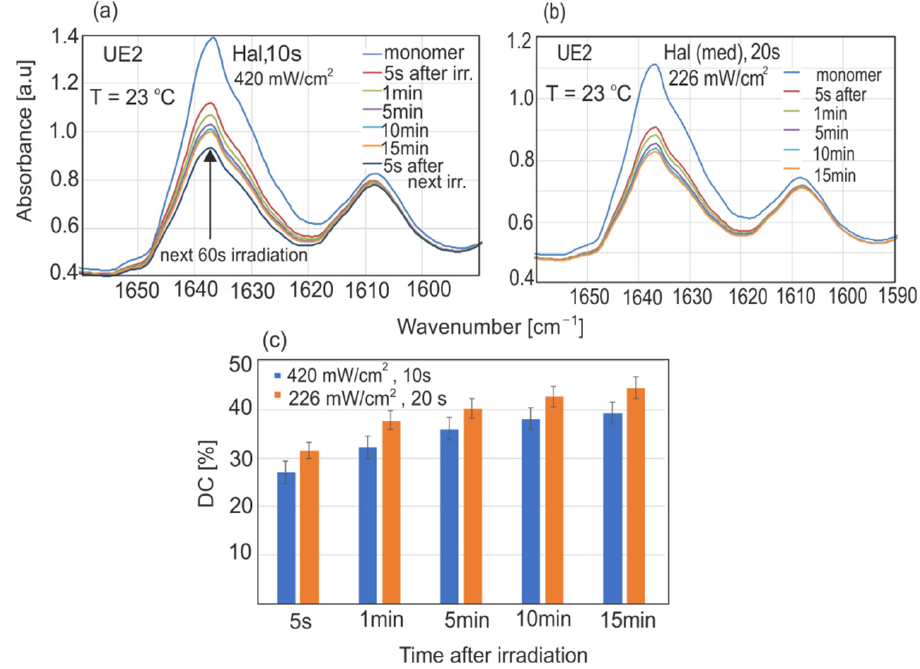
Figure 10. Light dose’s influence on the degree of conversion.